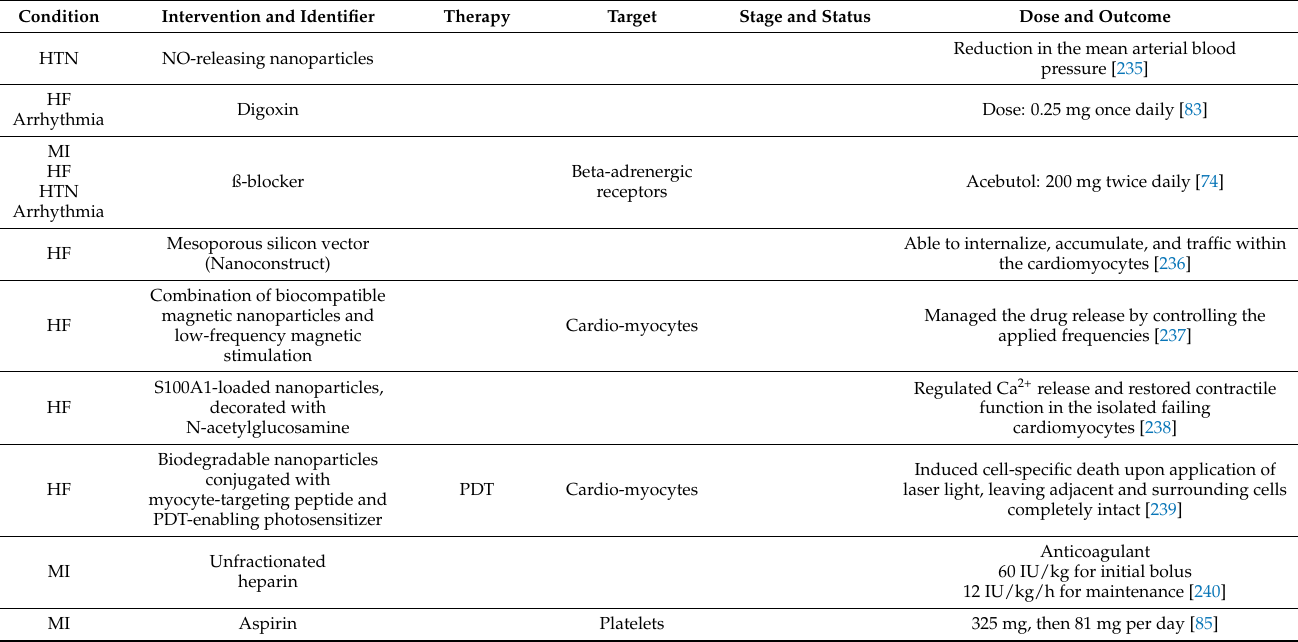
Table 6. Intravenous administration of medication as treatment for